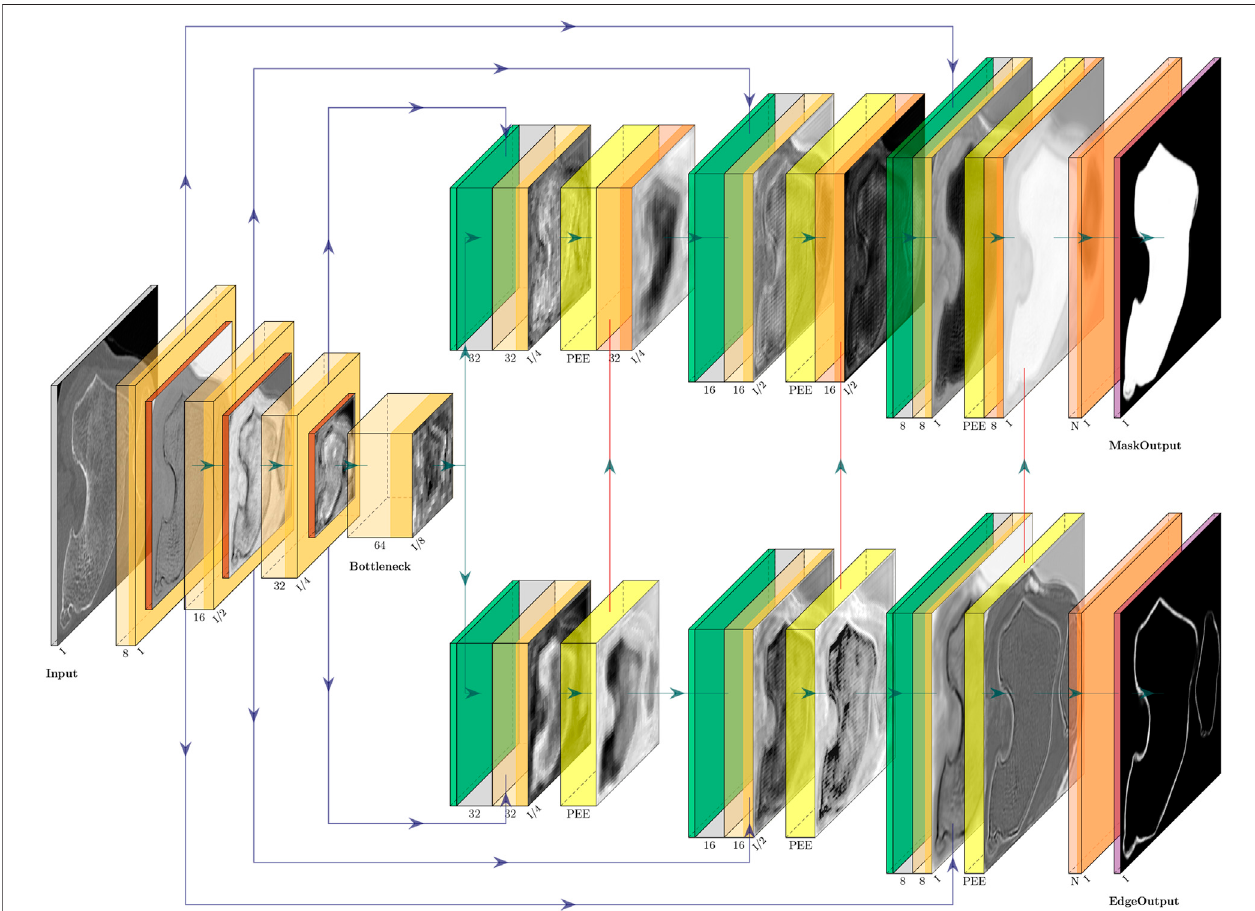
FIGURE1 | CEL-Unet architecture featuring three E – D layers. Left part representsthe encoding path endinginto the bottleneck level.Skip connections(horizontal blue connections) arise from the encoding path directed towards the two branches of up-sampling decoding path. The upper branch is devoted to the segmentation of bone regions. The lower decoding branch is devoted to edge detection. In order to enhance the region segmentation, the output (vertical red connections) of each decoding layer into the edge detection branch aggregates to the region decoding branch to the corresponding scale. Pyramidal edge extraction (PEE) is implemented in each level of the edge detection